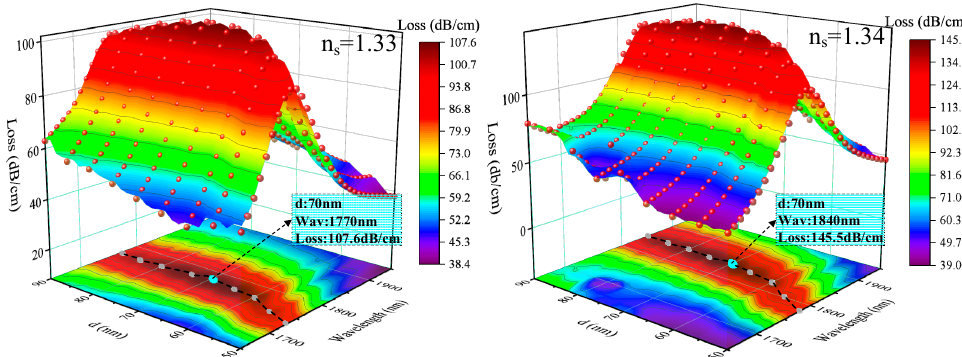
Figure 6. Diameter analysis of Au nanowires with RI of 1.33 and 1.34 in the analytes.